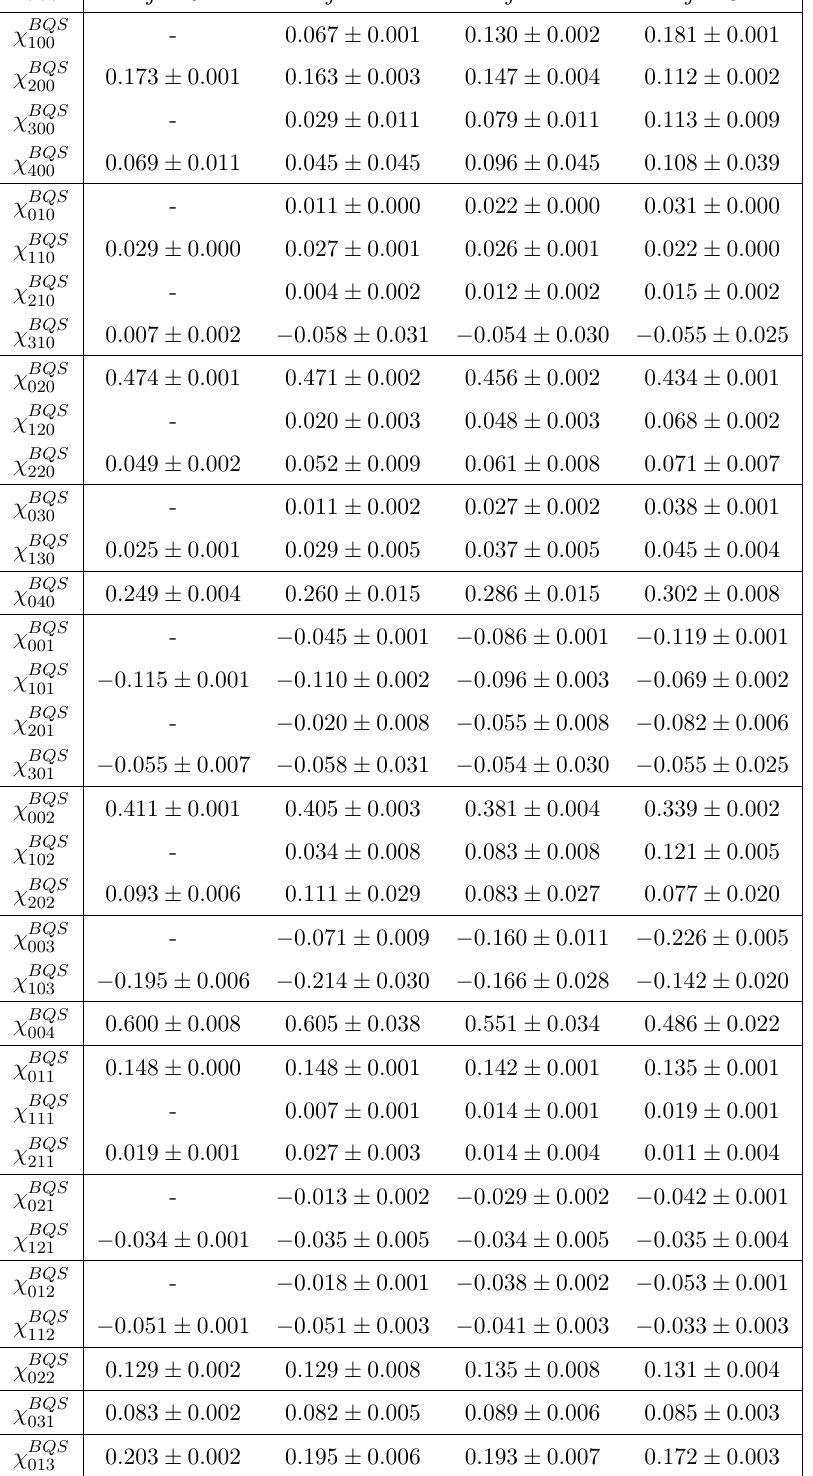
Table 5 . Raw data at T = 170 MeV and (cid:22) ( j )